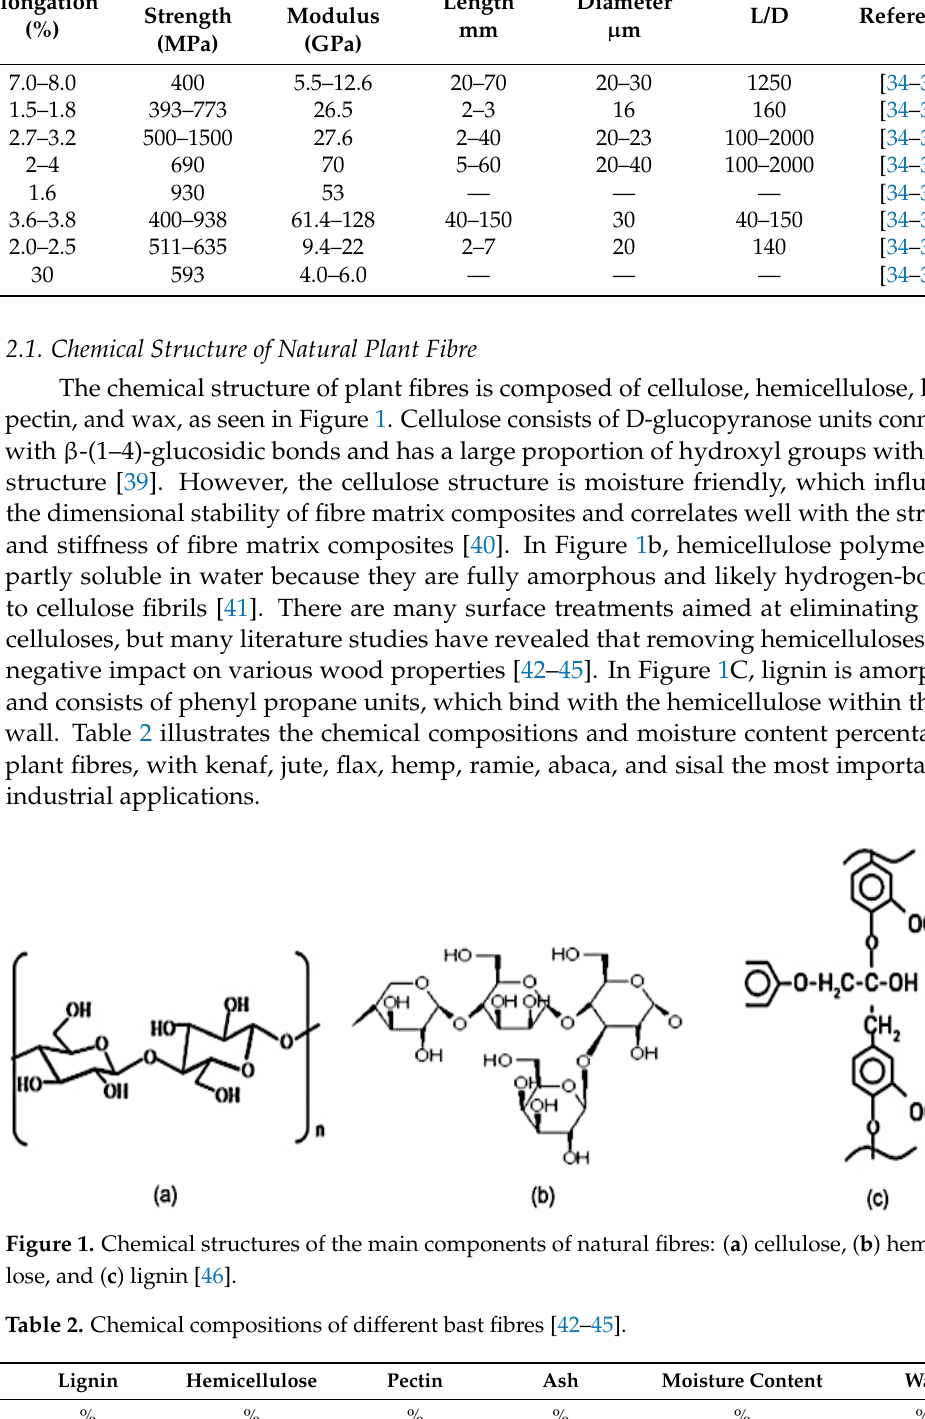
Table 1. Mechanical and physical properties of commonly used natural fibres.